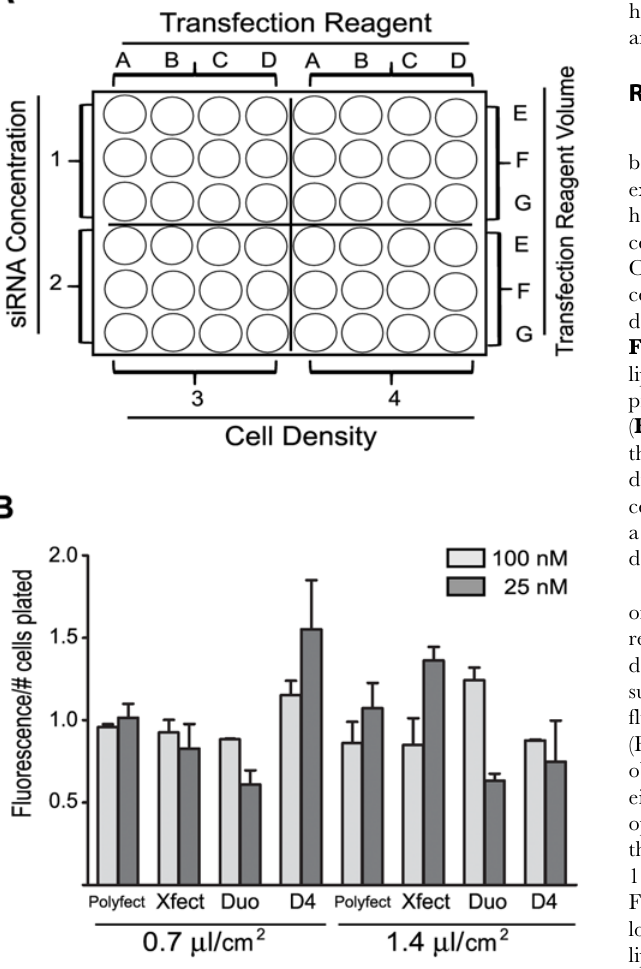
Figure 2. Optimization of siRNA transfection of adipocytes in suspension. (A) Grid layout for testing transfection variables based on a 48 well plate format. This grid accommodates testing two concentrations of siRNA (1,2) when transfecting cells at two densities/ cm 2 (3,4) with four transfection reagents (A,B,C,D) at three concentra- tions each (E, F, G). (B) Maximal fluorescent signal/cell number plated was obtained with three transfection reagents (D4, Duo, Xfect) at either 25 nM siRNA (D4 or Xfect) or 100 nM siRNA (Duo). The siRNA is siGLO RISC-free labeled with DY-547 (rhodamine filter). The cells were plated at 1.16 6 10 5 cells/cm 2 . The fluorescent signals were detected and quantitated using a Flexstation 2 fluorometer (Molecular Devices) and Softmax Pro 4.8 software. The fluorescent signal was assayed in triplicate, normalized to the number of cells plated/well, and reported as the mean and standard deviation from experiments carried out twice independently. Gel Electrophoresis and Immunoblotting Proteins were separated in polyacrylamide (National Diagnos- tics) gels containing sodium dodecyl sulfate (SDS) according to Laemmli [10] and transferred to nitrocellulose (BioRad) in 25 mM Tris, 192 mM glycine, and 20% methanol. Following transfer, the membrane was blocked in 4% milk for 1 hour at room temperature. The membranes were incubated with mouse monoclonal anti-PPAR c (1:125 dilution), rabbit polyclonal anti- lamin A/C (1:200 dilution), or rabbit polyclonal anti-E6-AP (1:2000 dilution) as indicated for 1–2 hours at room temperature.